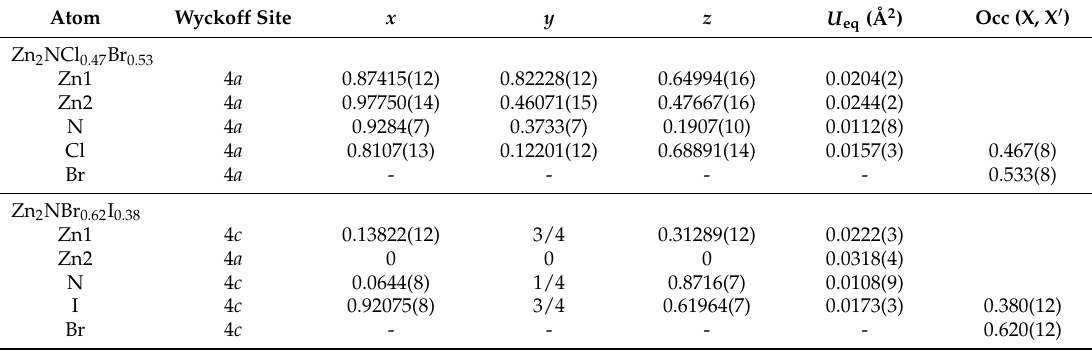
Table 3. Refined atomic coordinates and equivalent isotropic displacement parameters